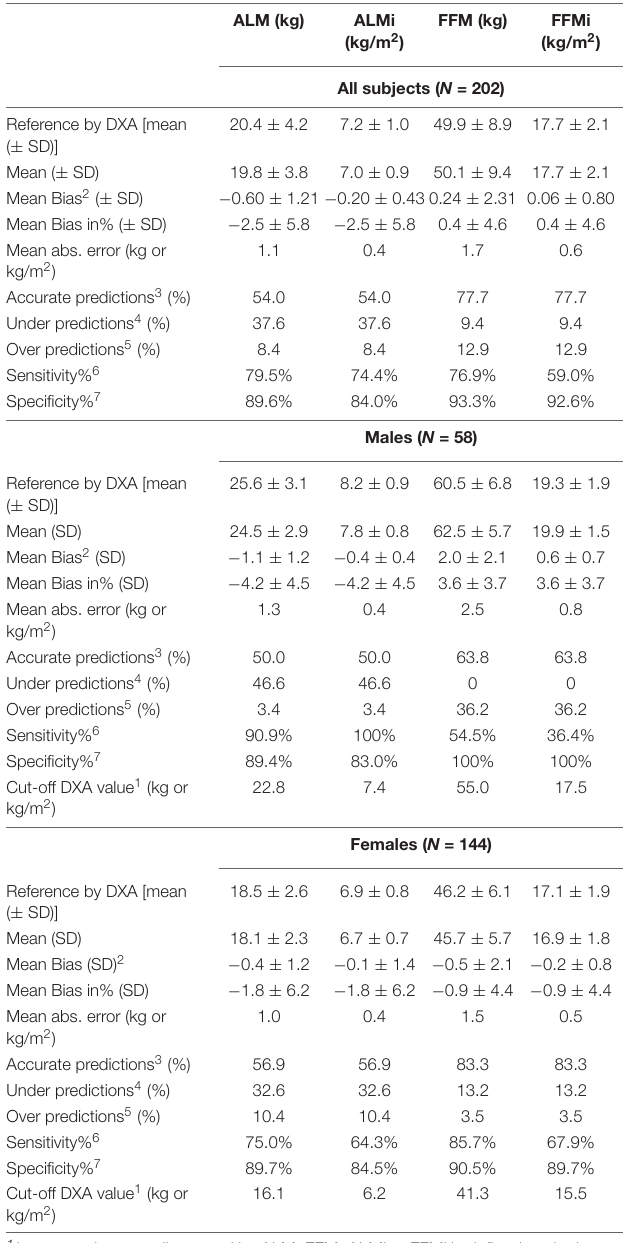
TABLE 2 | Evaluation of the validity of appendicular lean mass (ALM), fat free mass (FFM), ALM-index (ALMi), and FFM-index (FFMi), including sensitivity and specificity of diagnosing low muscle mass, assessed by BIA with DXA as reference 1 in 202 subjects of 55 years and